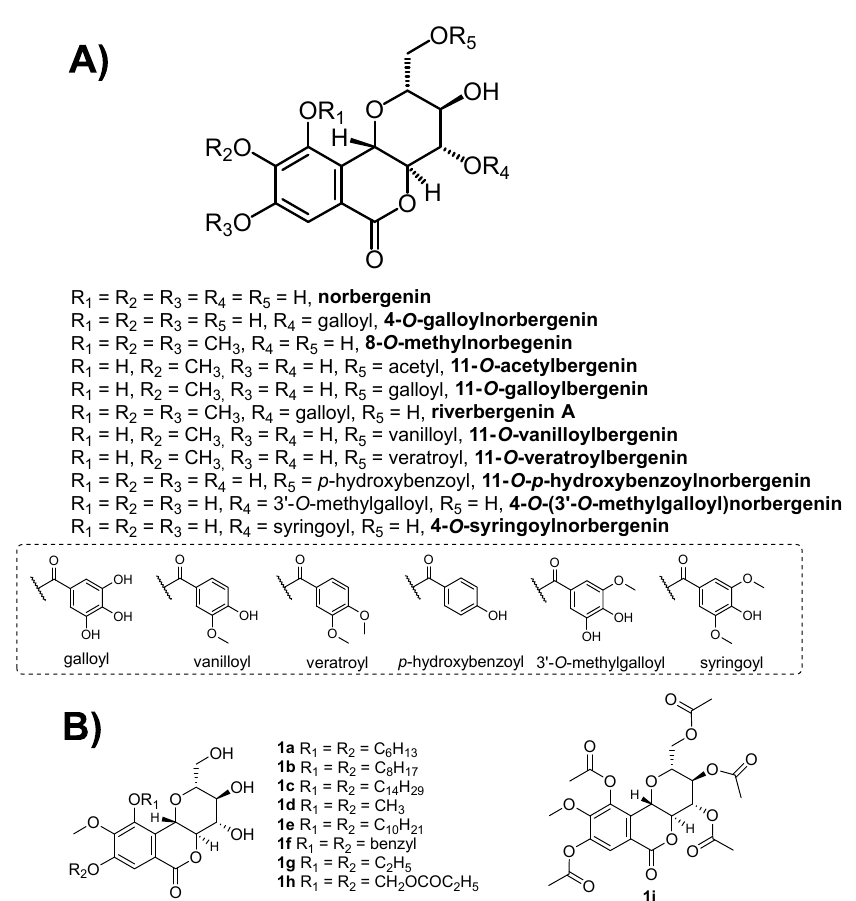
Figure 2. ( A ) natural derivatives of bergenin isolated from different plant species and ( B ) semisynthetic derivatives obtained by modulation of bergenin in the laboratory.